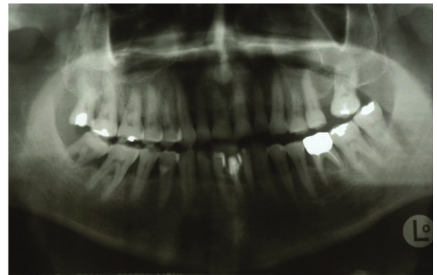
Figure 1: Preoperative orthopantomography.